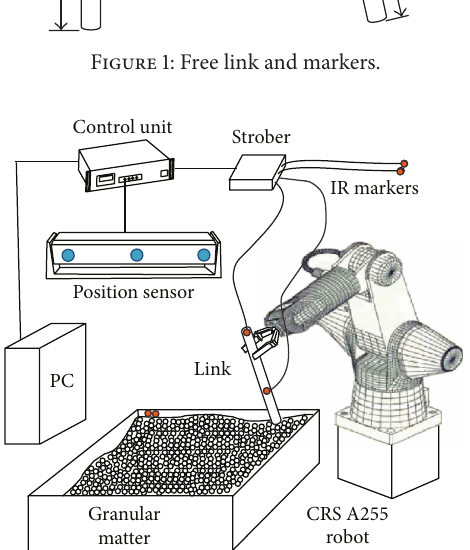
Figure 2: Motion measurement